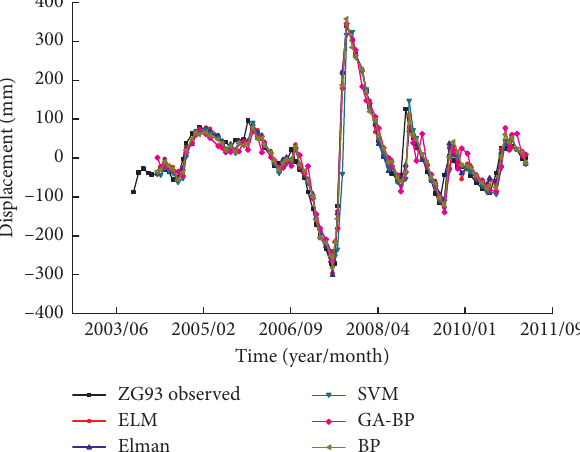
Figure 11: Fitting performance through other models on point ZG93 in the Baishuihe landslide displacement.